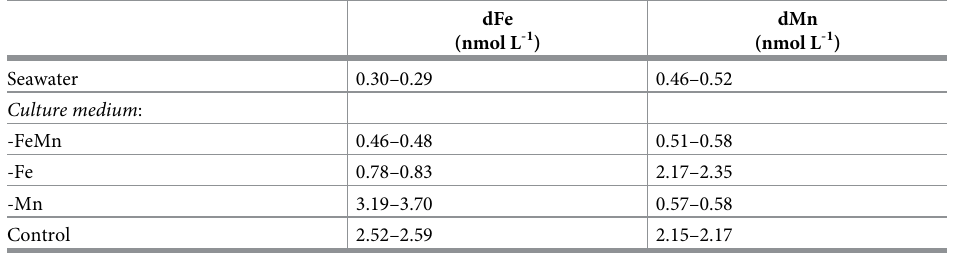
Table 1. Total dissolved Fe (dFe) and Mn (dMn) concentrations from the natural Antarctic seawater as well as from the four different treatments (-FeMn, -Fe, -Mn, control) were determined in the culture medium (0.2 μ m fil- tered Antarctic seawater). Values represent the range of duplicate measurements of the different culture